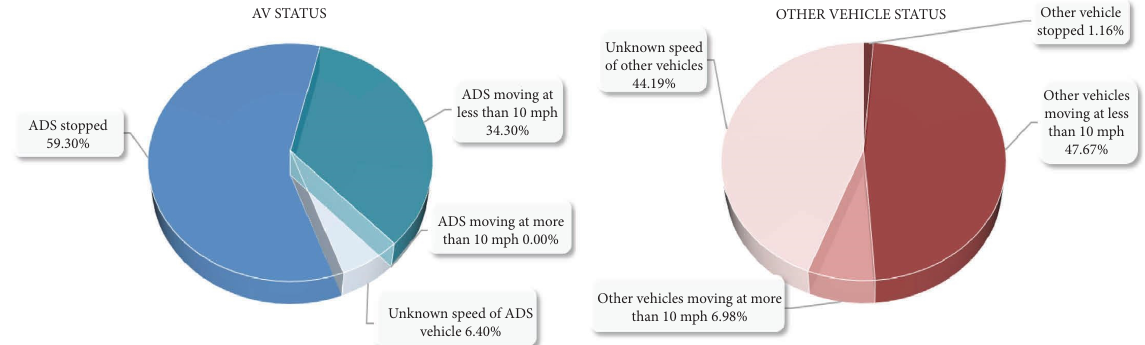
Figure 4: Moving status for the 2015–2021 California DMV AVT rear-end ADS